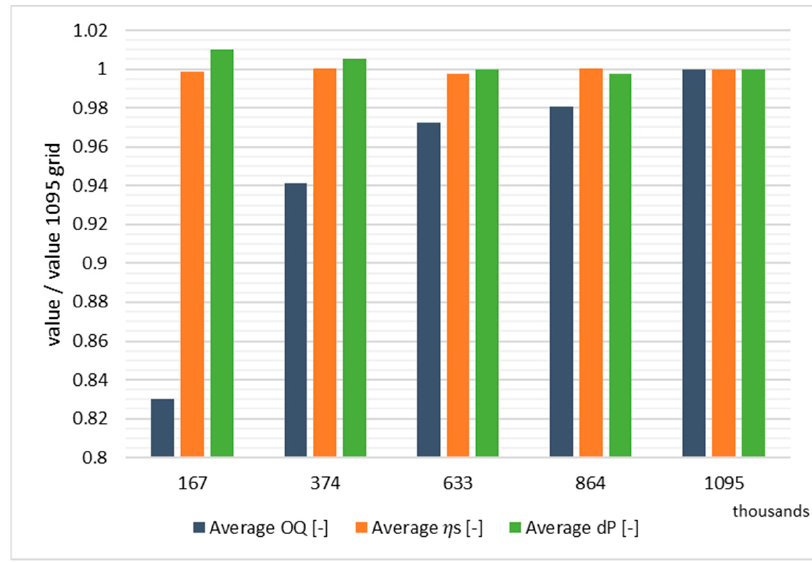
Figure 3. Mesh impact on the analysed parameters (reference value for 1095k mesh).